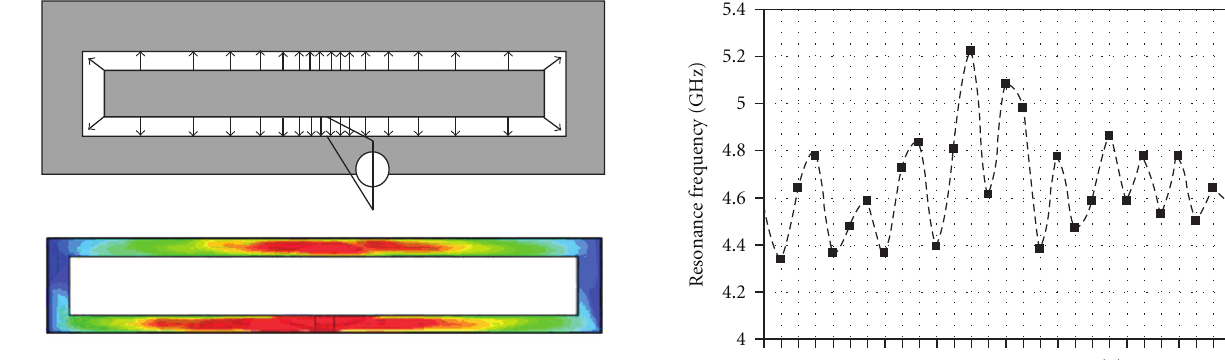
Figure 2: Electrical field strength on the slot, theoretical and simu- lated.